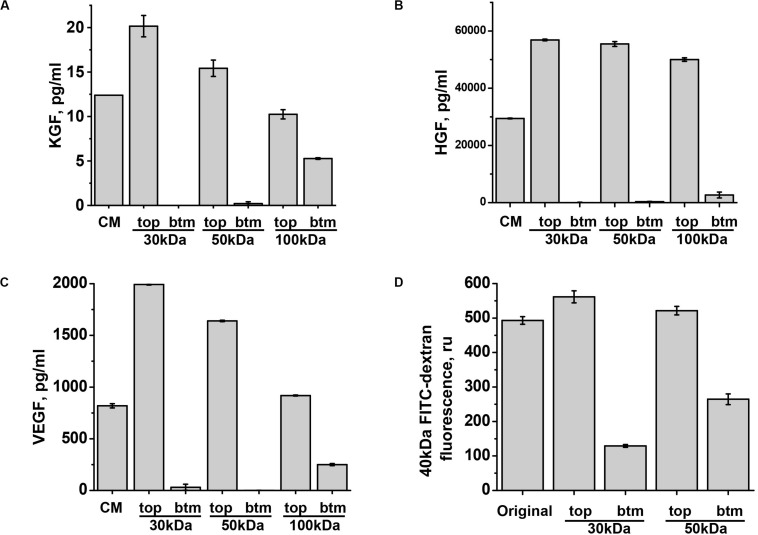
KGF, HGF, and VEGF partition in the fraction with MW exceeding 50 kDa. (A–C) ASC-CM was generated over the period of 48 h. KGF, HGF, and VEGF concentrations were determined in the original ASC-CM (CM), and top (tp) and bottom (bt) fractions generated by filtration through indicated MW cutoff membranes. Data from three independent experiments are presented. (D) 40 kDa FITC-dextran was filtered via indicated MW cutoff membranes; fluorescence levels of the original solution and top and bottom fractions are presented.